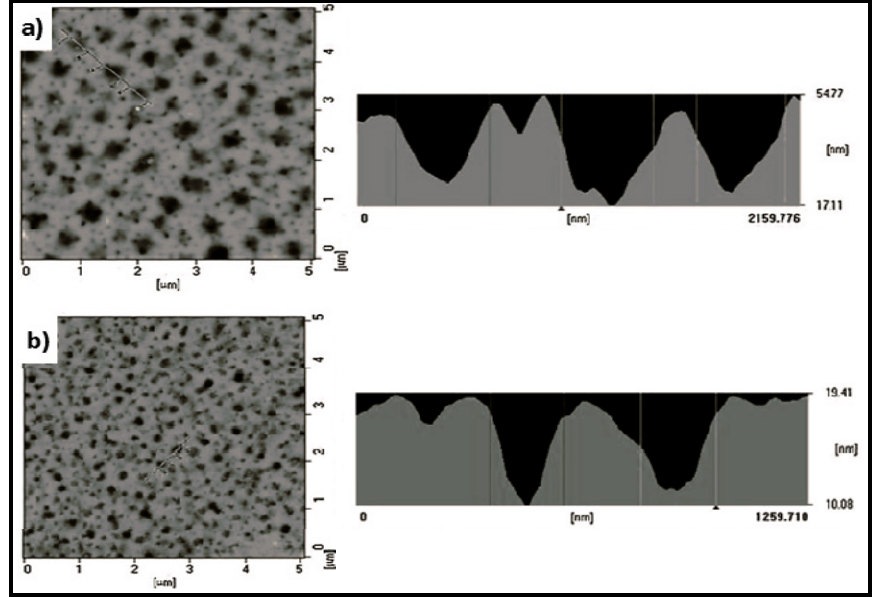
Figure 8. Atomic force microscopy (AFM) images of PLLA/PGAT samples containing ( a ) 33 wt % and ( b ) 10 wt % of PGAT. Reprinted with permission from [42]. Copyright 2011 WILEY-VCH Verlag GmbH &